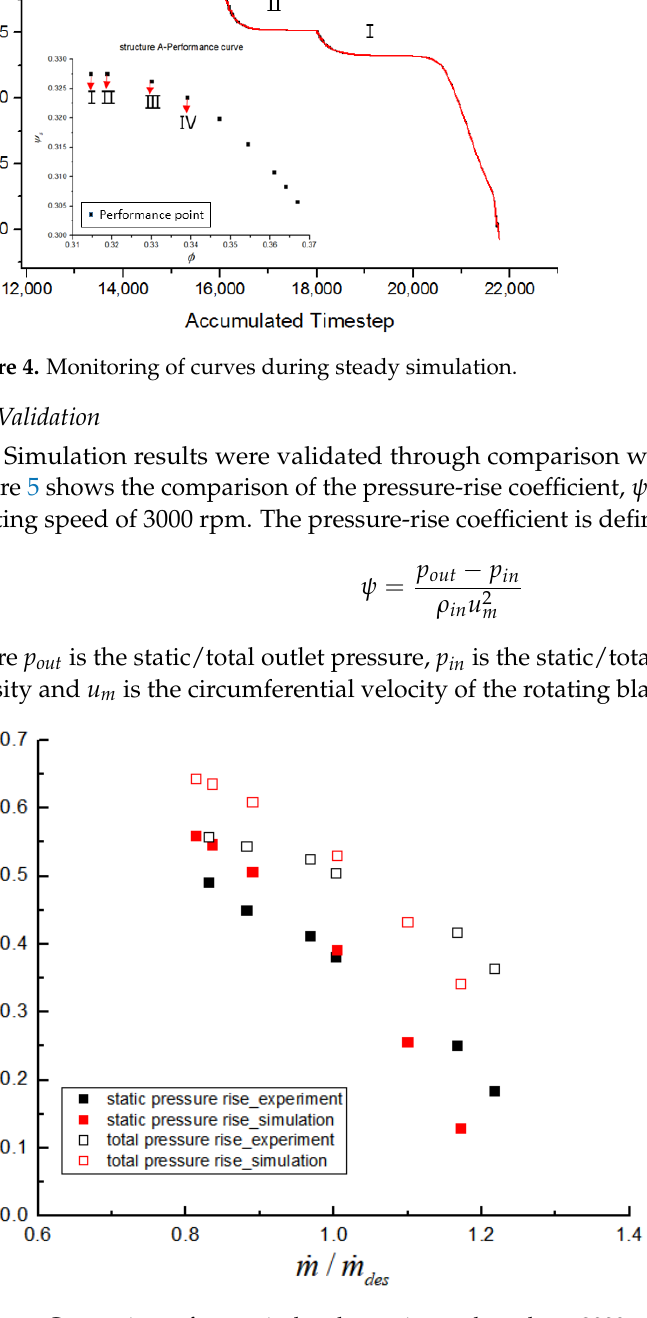
with the increasing deviation of mass flow rate from the design point. Improvement of the numerical simulation method was considered to further depress the